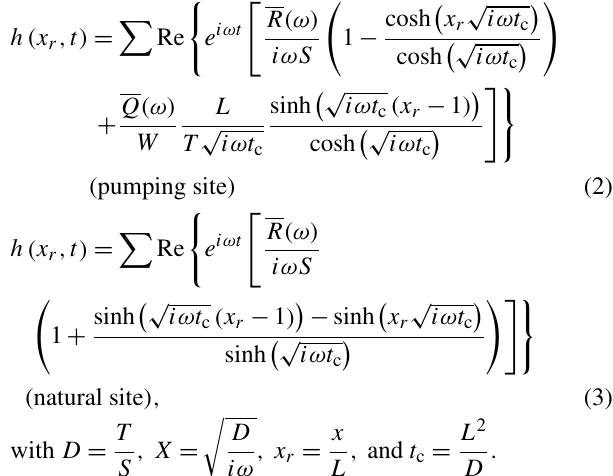
leads to Eq. (2) and (3) describing WTFs ( h(x r ,t) ). The derivation of these equations is provided in Appendix